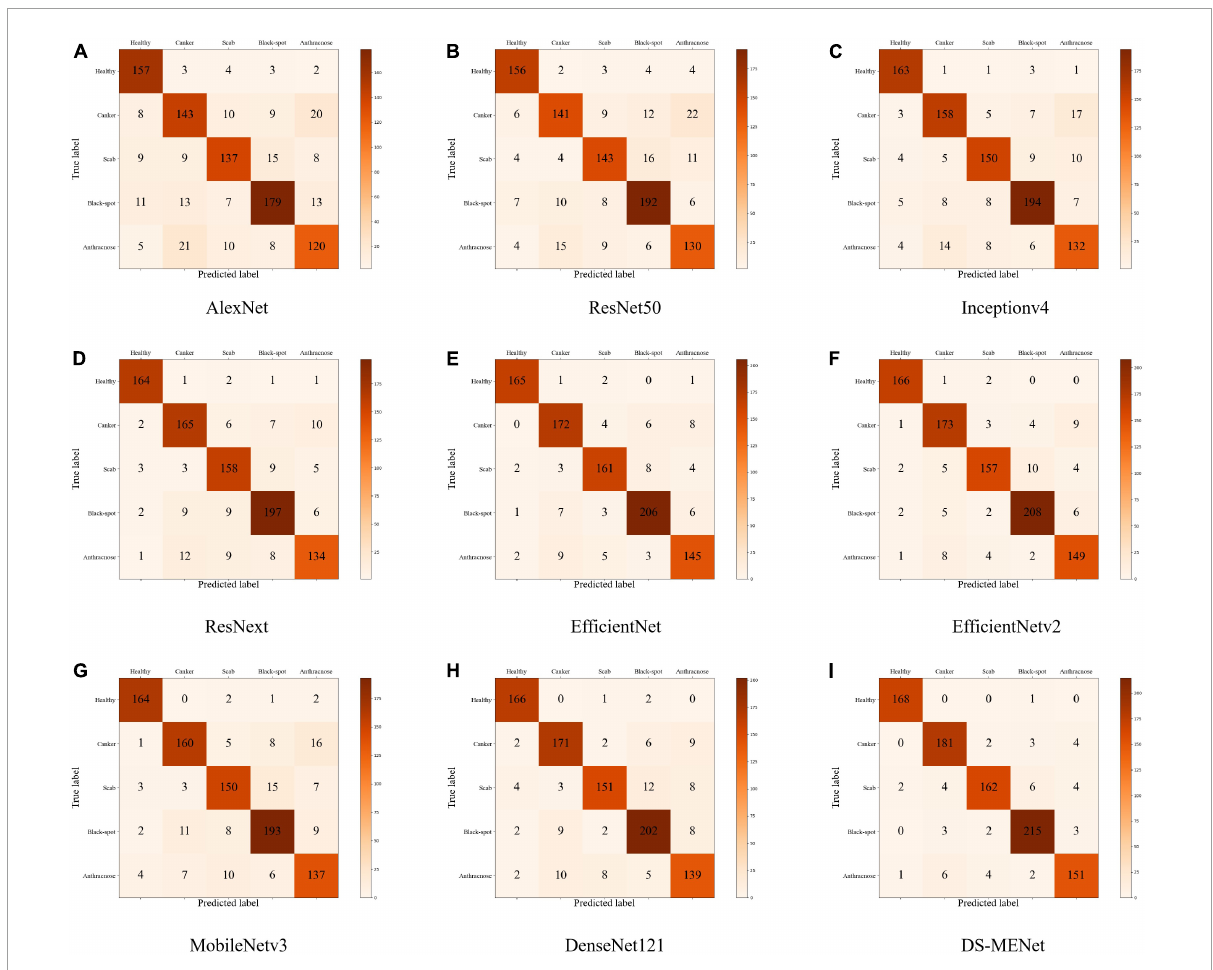
FIGURE12 Classification confusion matrix of citrus diseases by different models (the models corresponding to the (A–I) confusion matrix are: AlexNet, ResNet50, Inceptionv4, ResNext, EfficientNet, EfficientNetv2, MobileNetv3, DenseNet121, and DS-MENet).